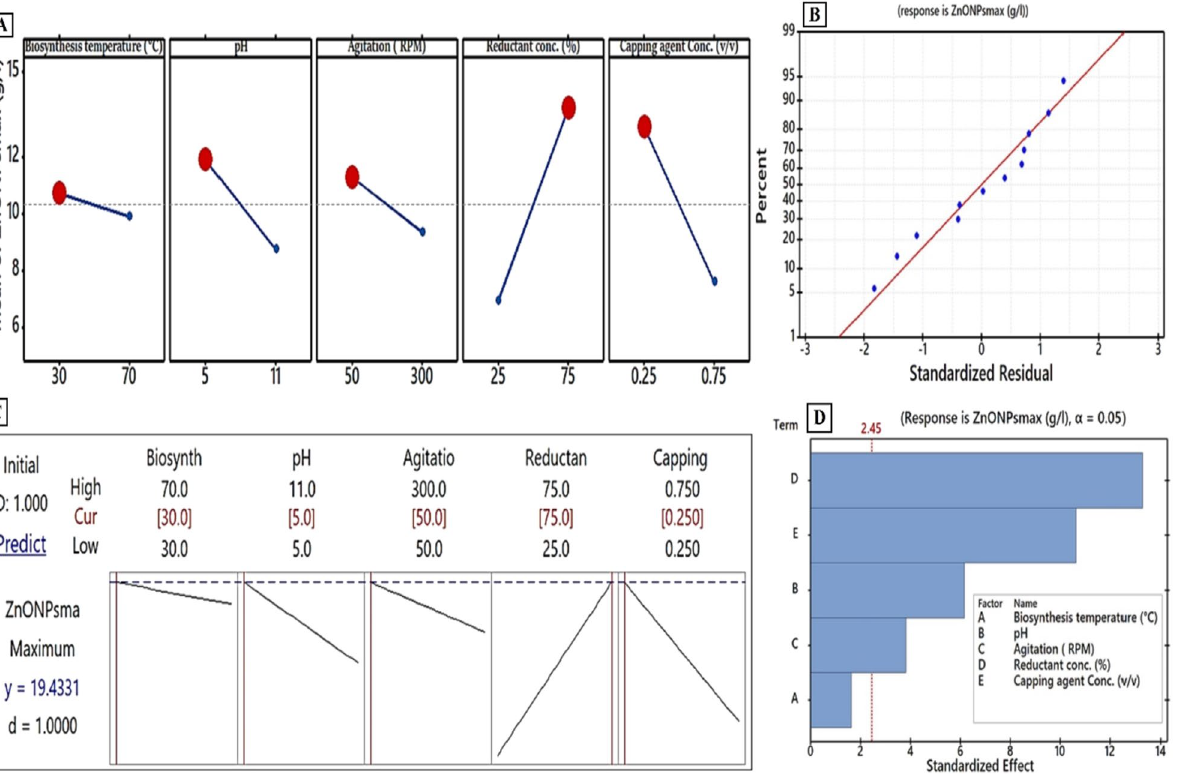
Figure 5. ( A ) The main effect plot of each evaluated variable on the dry weight of the biosynthetic ZnO NPs using Plackett–Burman design ( C ) a response optimizer with an expected control system for the ZnO NPs bio-synthesis reaction, with a maximum outcome and optimal values of variables investigated. ( B ) A residual normal probability plot. ( D ) The Pareto chart of standardized